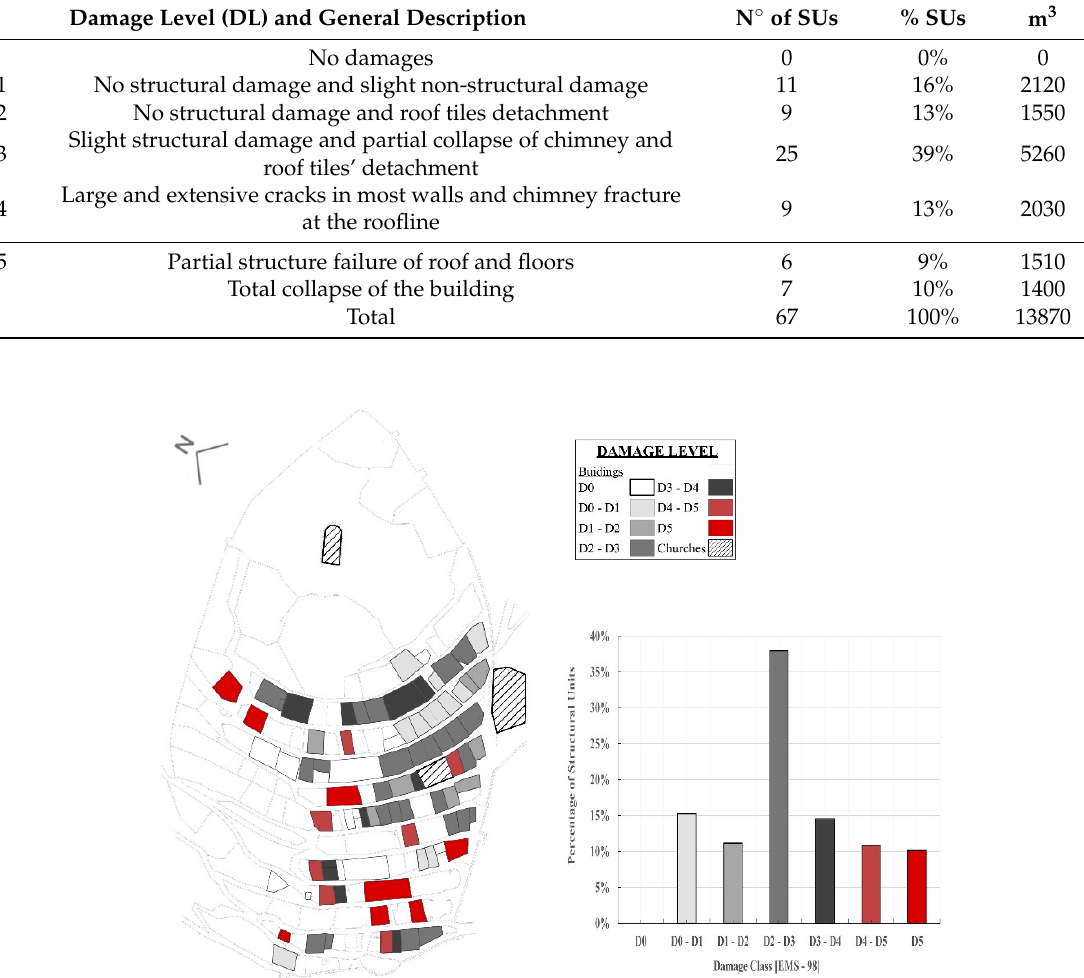
Figure 7. Comparison between the damage level and different retrofit typologies carried out before the seismic.